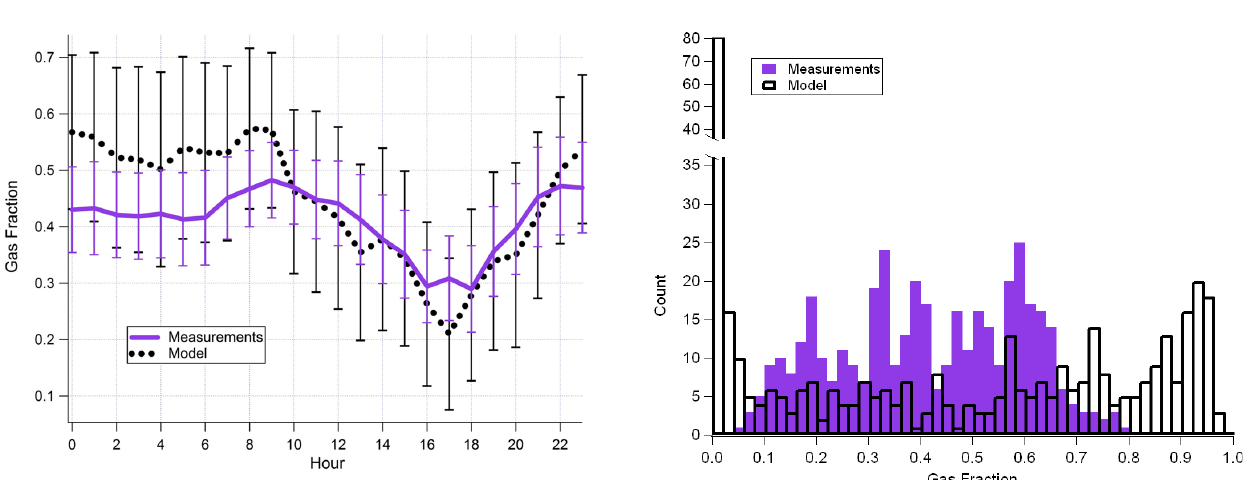
Fig. 8. Histogram of the measured and modelled gas fraction NH 3 /NH x